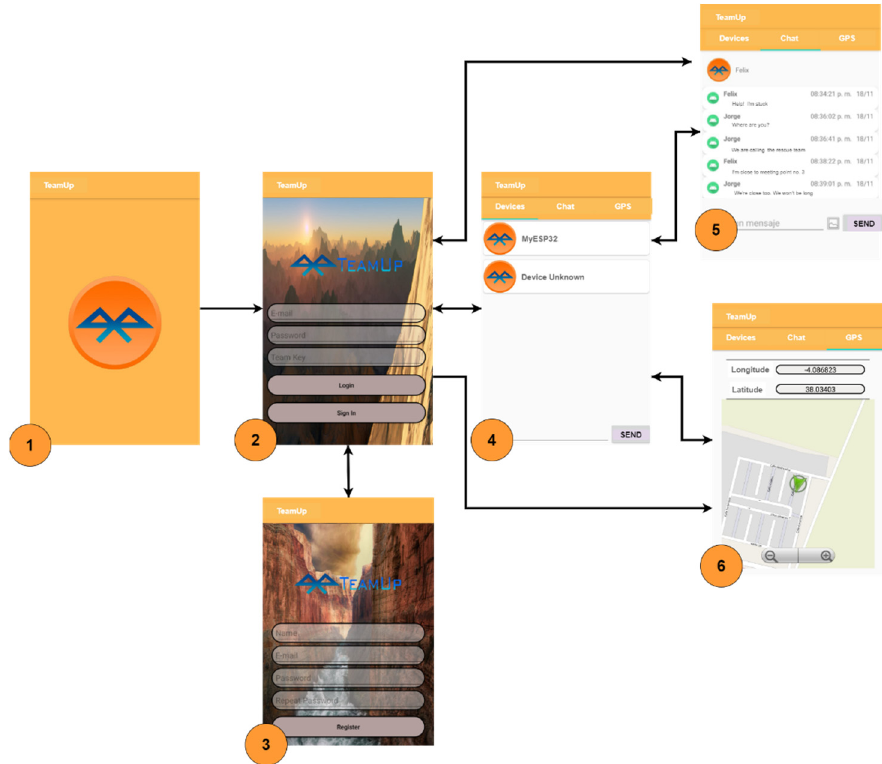
Figure 6. TeamUp application navigation. First, the users launch the application and register. If they are registered, they can log in and connect to the mote in the Devices Table. Then, the users are in a position to send a location by activating the GPS tab and send messages via the Chat tab.